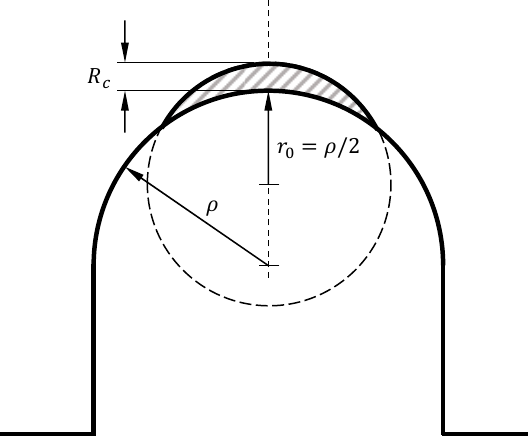
Figure 5. Control volume for a U-notch under mode I loading.